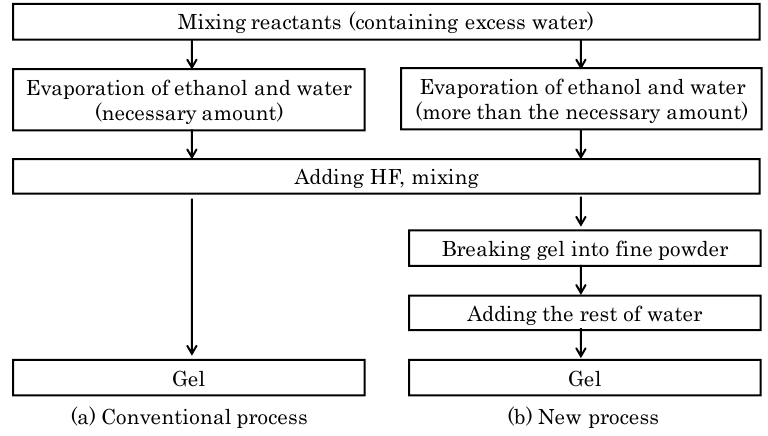
Figure 11. Preparation of the synthesis gel: ( a ) conventional process; ( b ) new process.